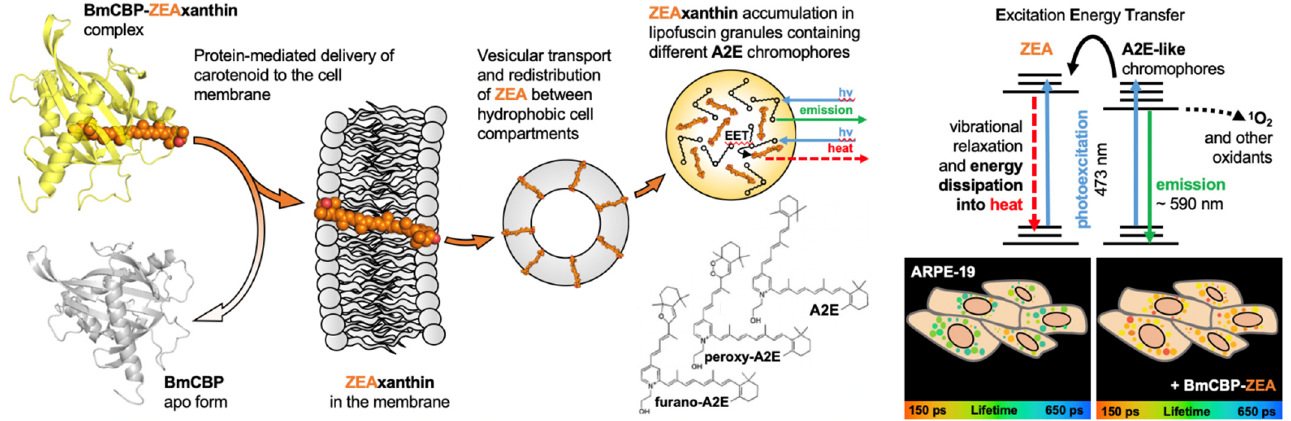
Figure 7. Schematic representation of the effects of protein-mediated delivery of zeaxanthin to ARPE-19 cells containing lipofuscin granules. The structure of water-soluble BmCBP (yellow cartoon, according to PDB ID 7ZVR) allows it to effectively bind zeaxanthin (ZEA, shown as orange spheres). When it contacts ARPE-19 cell membranes, the carotenoid is transferred into the membrane and an apoform of the protein (grey cartoon, according to PDB ID 7ZTQ) is formed. Further, probably through basic cellular transport mechanisms, carotenoids can be redistributed between the membranes of various cell organoids including mitochondria. Due to their high hydrophobicity and a certain similarity of chemical structures of carotenoids and A2E-like chromophores, carotenoids can be transported into lipofuscin granules. The close proximity of zeaxanthin and the main lipofuscin fluorophores (A2E) can lead to an energy coupling that results in a reduction in the fluorescence quantum yield of the lipofuscin fluorophores detected by FLIM. Energy transfer to zeaxanthin, as well as its direct photoexcitation, leads to rapid energy dissipation, which ultimately reduces the probability of generation of reactive oxygen species and suppresses the oxidative stress.